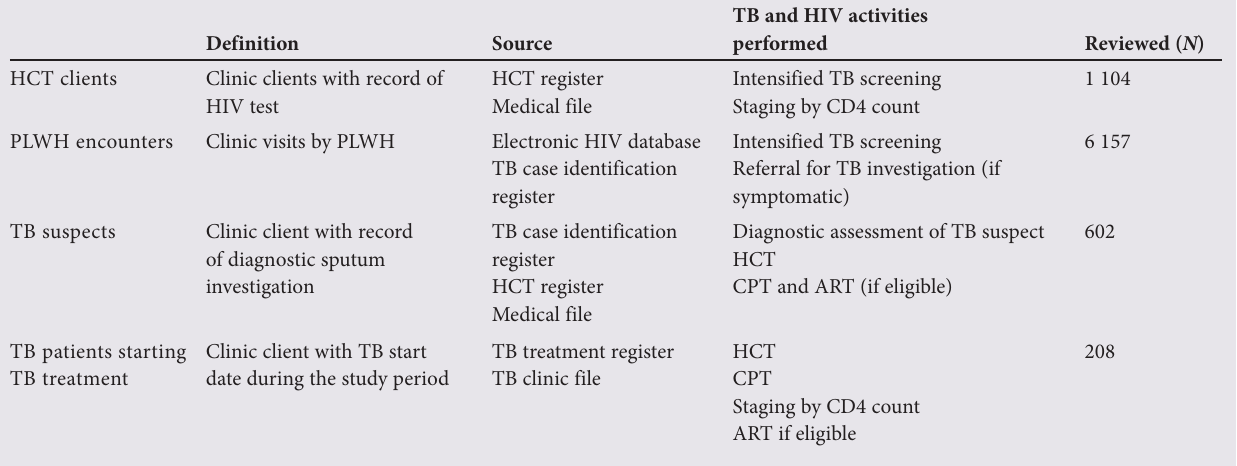
Table 1. Definition of study participants, data sources and activities